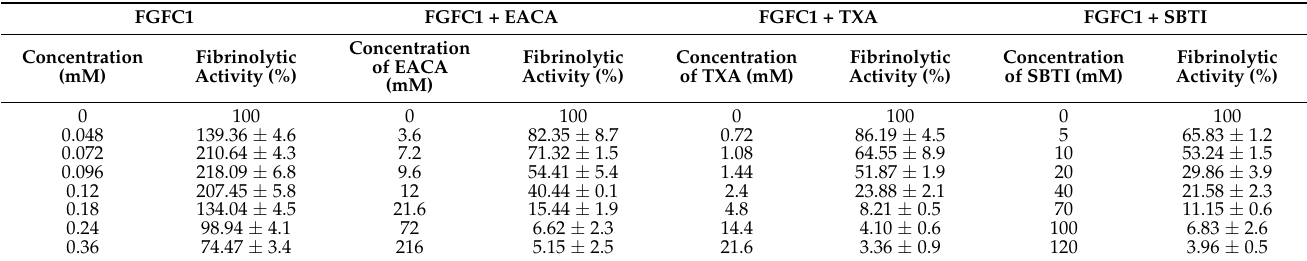
Table 1. The effect of different 6-aminohexanoic acid (EACA), tranexamic acid (TXA), and soybean trypsin inhibitor (SBTI) concentrations on the fibrinolytic activity of